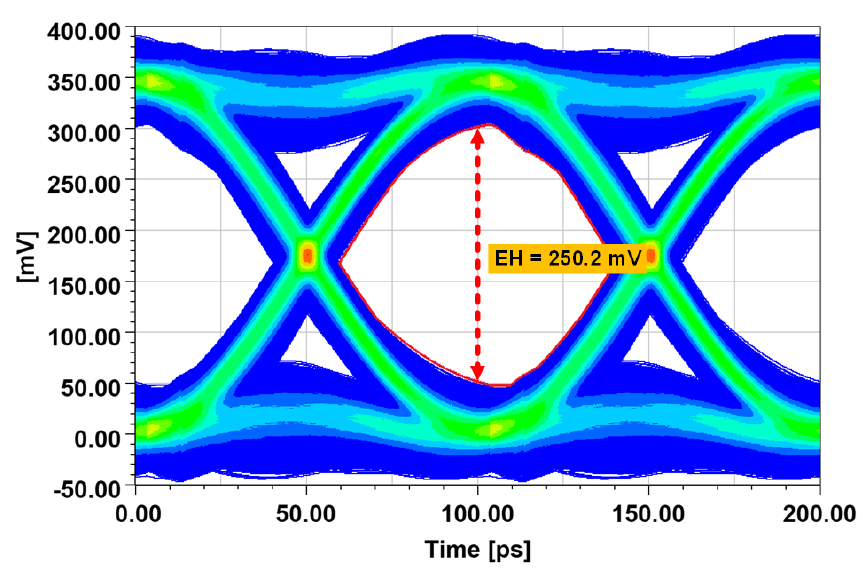
Figure 8. Eye diagram for W = 25 µ m, K D = 2 at V TX = 0.75 V.